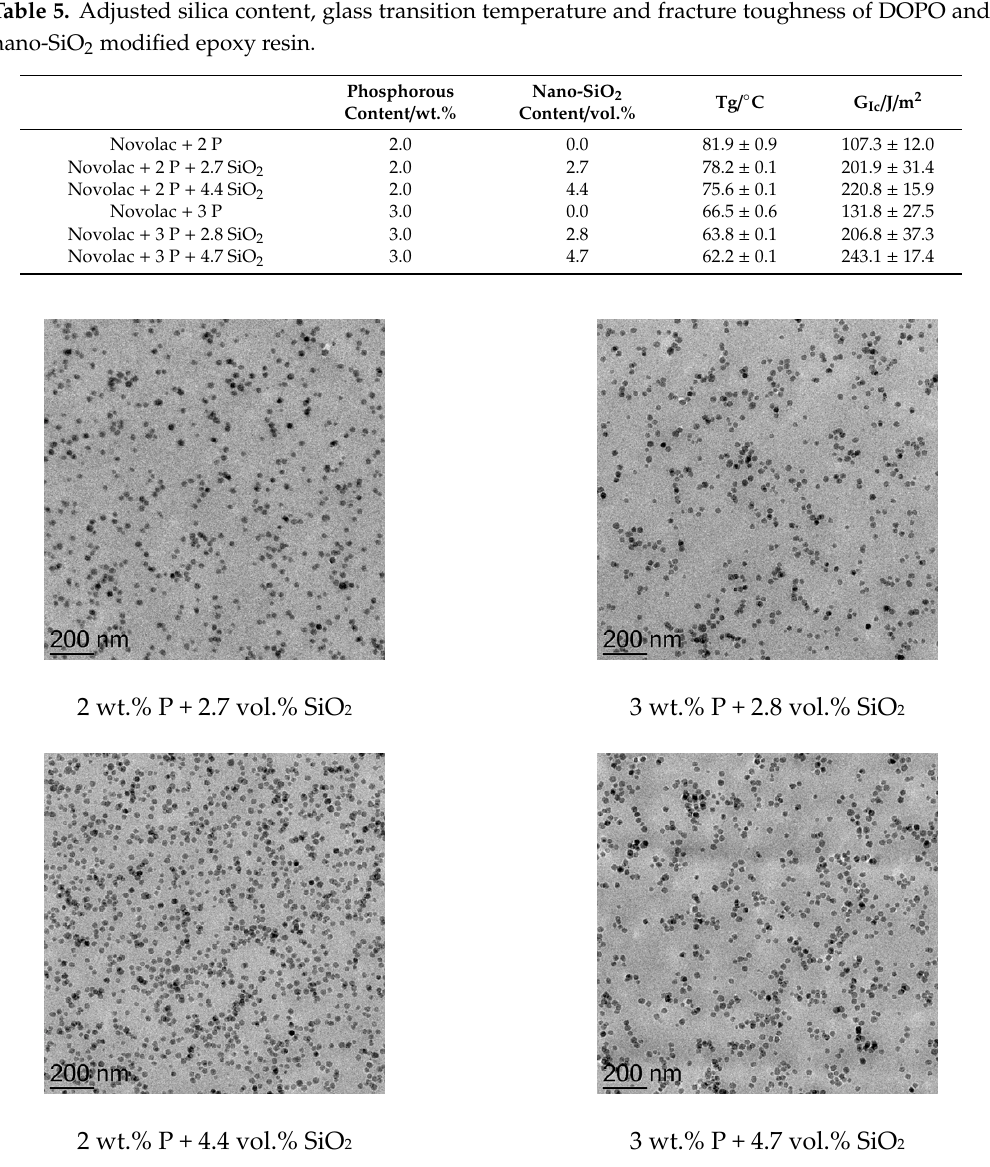
Figure 6. Transmission electron microscopy images of composites with 2 wt.% (left) and 3 wt.% (right) phosphorous and comparable silica content.